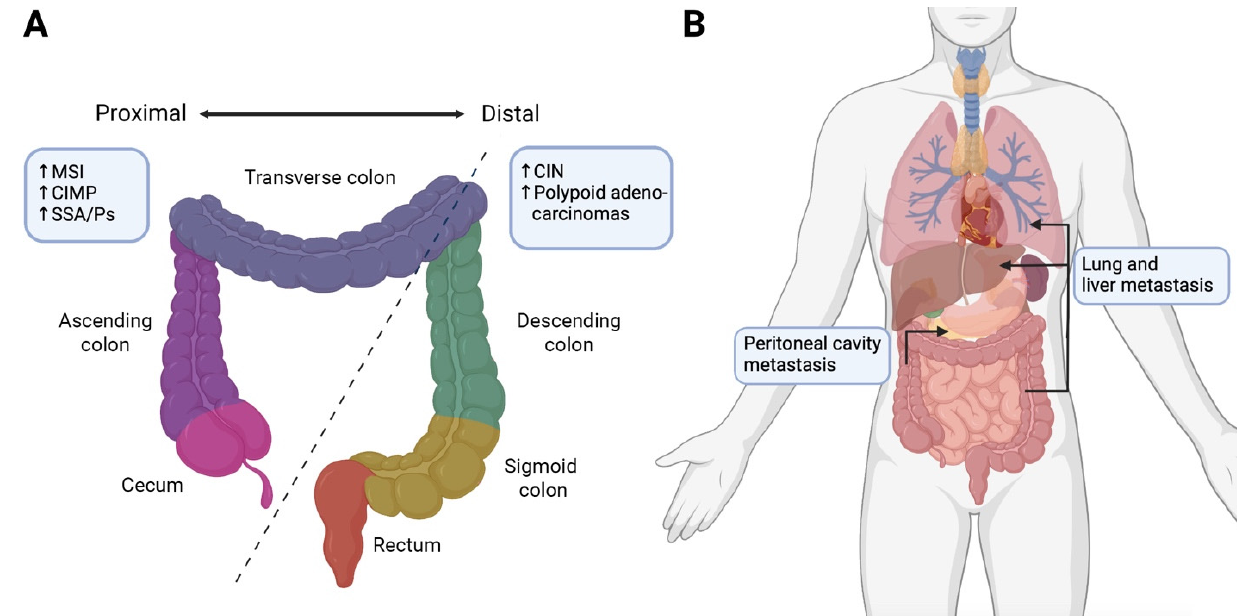
Figure 1. Anatomy of the colon and rectum and predominance of metastatic sites relative to proximal and distal CRCs. ( A ) Prevalence of distinct features varying between proximal and distal CRCs. ( B ) Predominant metastatic sites according to CRC sidedness: proximal CRCs majorly metastasize to the peritoneal cavity, whereas distal CRCs metastasize to the lungs and the liver. MSI, microsatellite instability; CIMP, CpG island methylator phenotype; CIN, chromosome instability; SSA/P, sessile serrated adenoma/polyp.